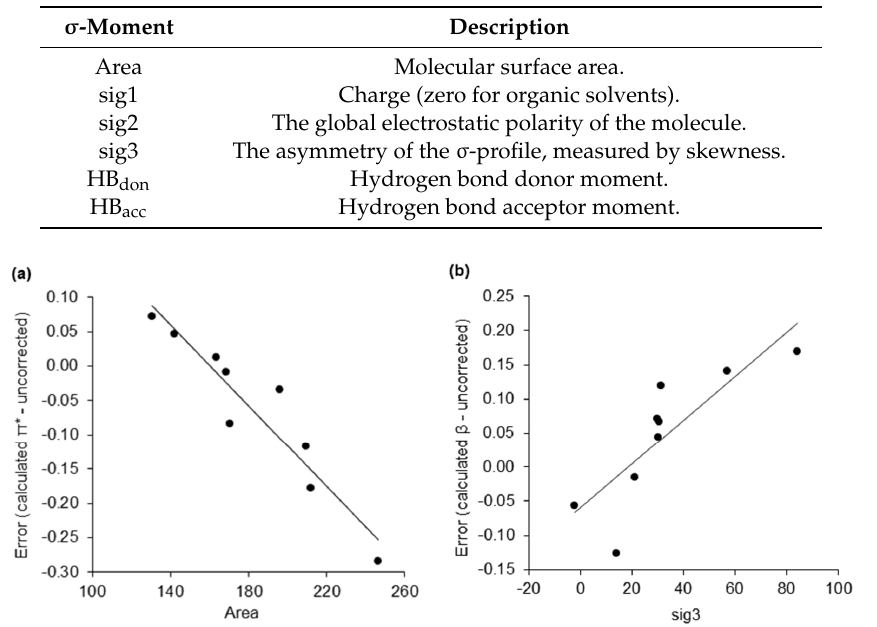
Table 1. Definitions of σ -moments.